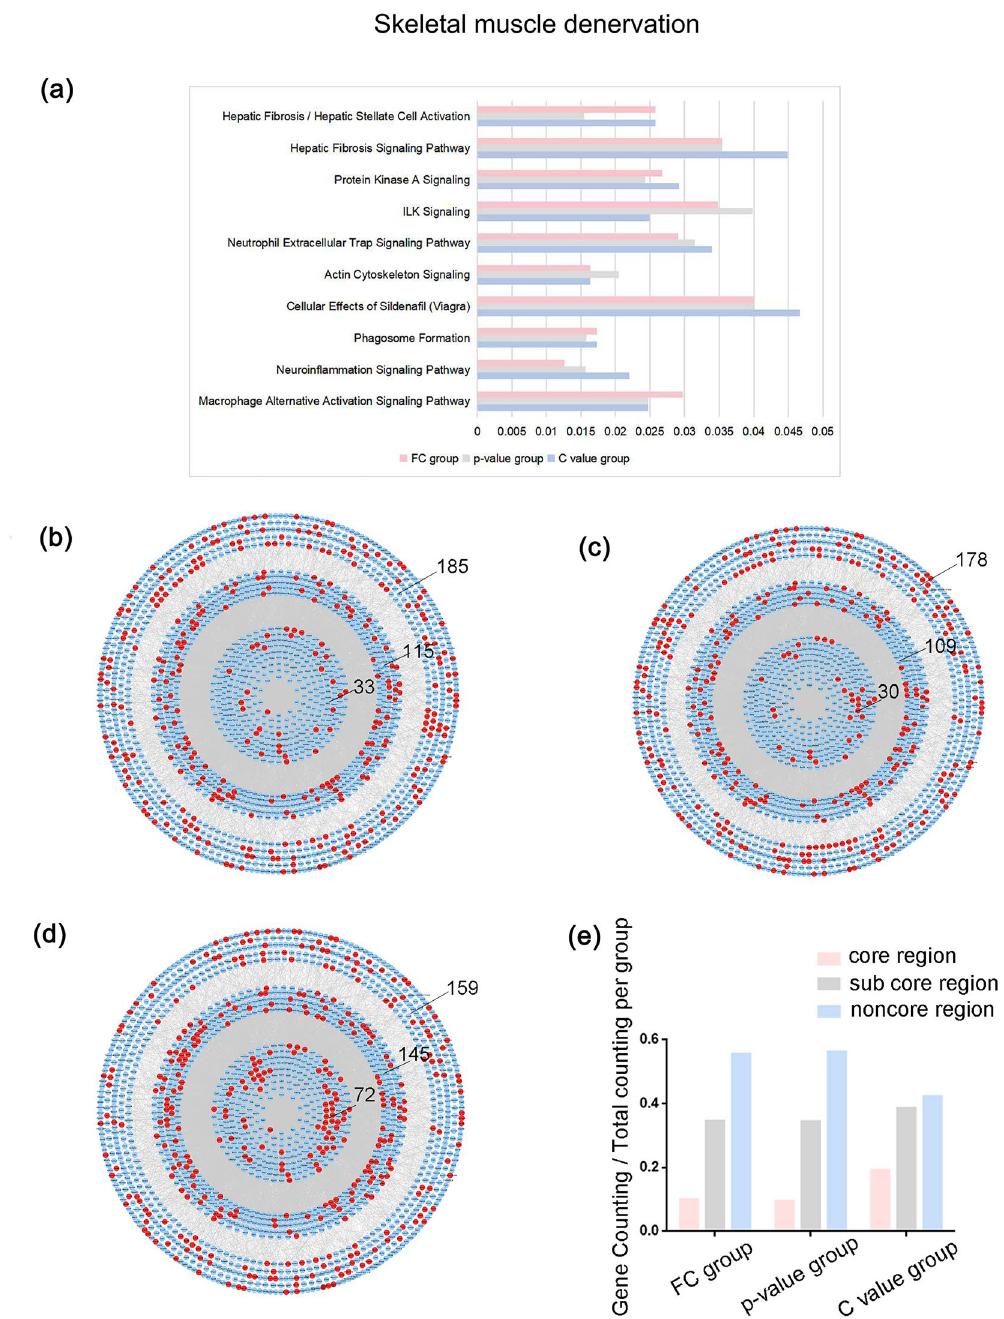
Figure 5. LncRNA operation results for skeletal muscle denervation data set ( a ) The ratio of predicted target genes to the total genes in IPA canonical pathways. The distribution of ( b ) top10 FC, ( c ) top10 p-value and ( d ) top10 C value lncRNAs’ predictive target mRNAs in the PPI network. Number of genes in core region, sub core region and noncore region of each group was tagged. ( e ) The ratio of the number of genes in each group in different regions. (FC group: the collection of the top10 FC lncRNAs’ predictive target mRNAs; p-value group: the collection of the top10 p-value lncRNAs’ predictive target mRNAs; C value group: the collection of the top10 C value lncRNAs’ predictive target